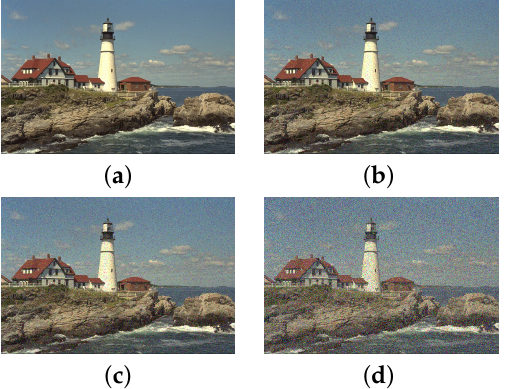
Figure 10. Decrypted images undergo the salt and pepper noise with a density of: ( a ) 0.005, ( b ) 0.05, ( c ) 0.100, and ( d )